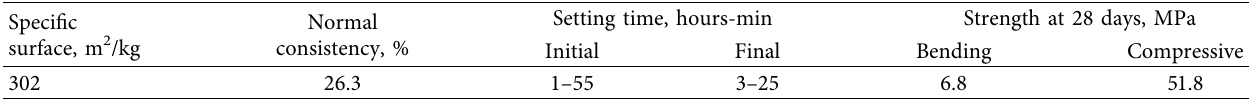
Table 3: Physical and mechanical properties of Portland cement.